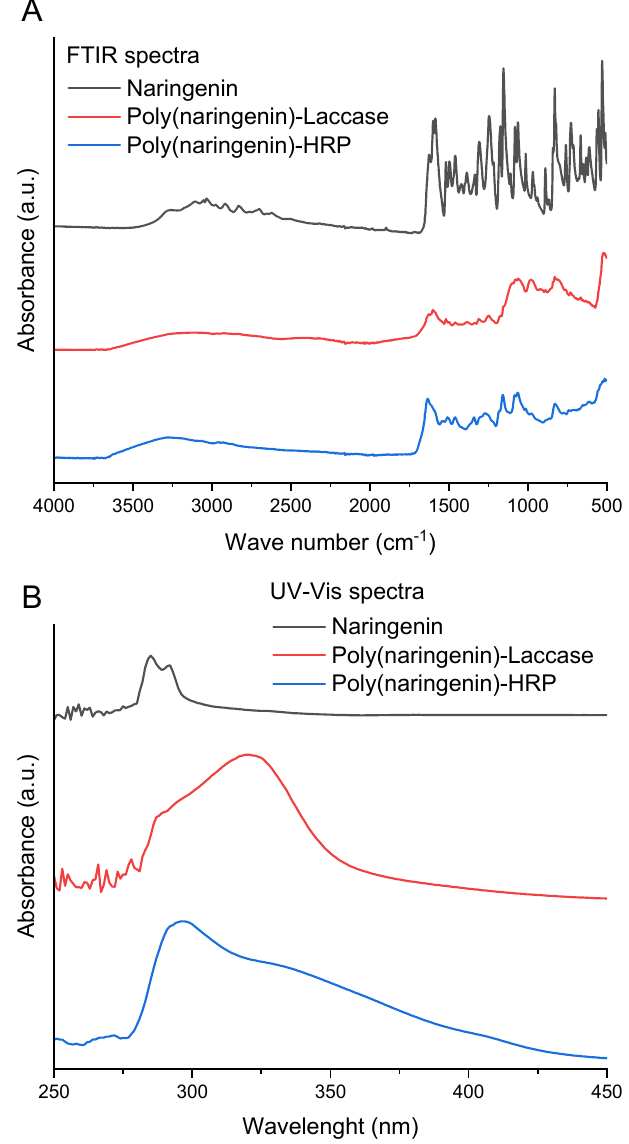
Figure 1. ( A ) FTIR spectroscopy and ( B ) UV-Vis spectroscopy of naringenin, poly(naringenin)-laccase and poly(naringenin)-HRP.